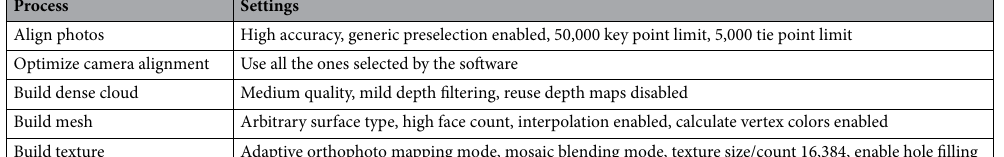
Table 2. Settings used to generate 3D models in Agisoft Photoscan/Metashape Professional